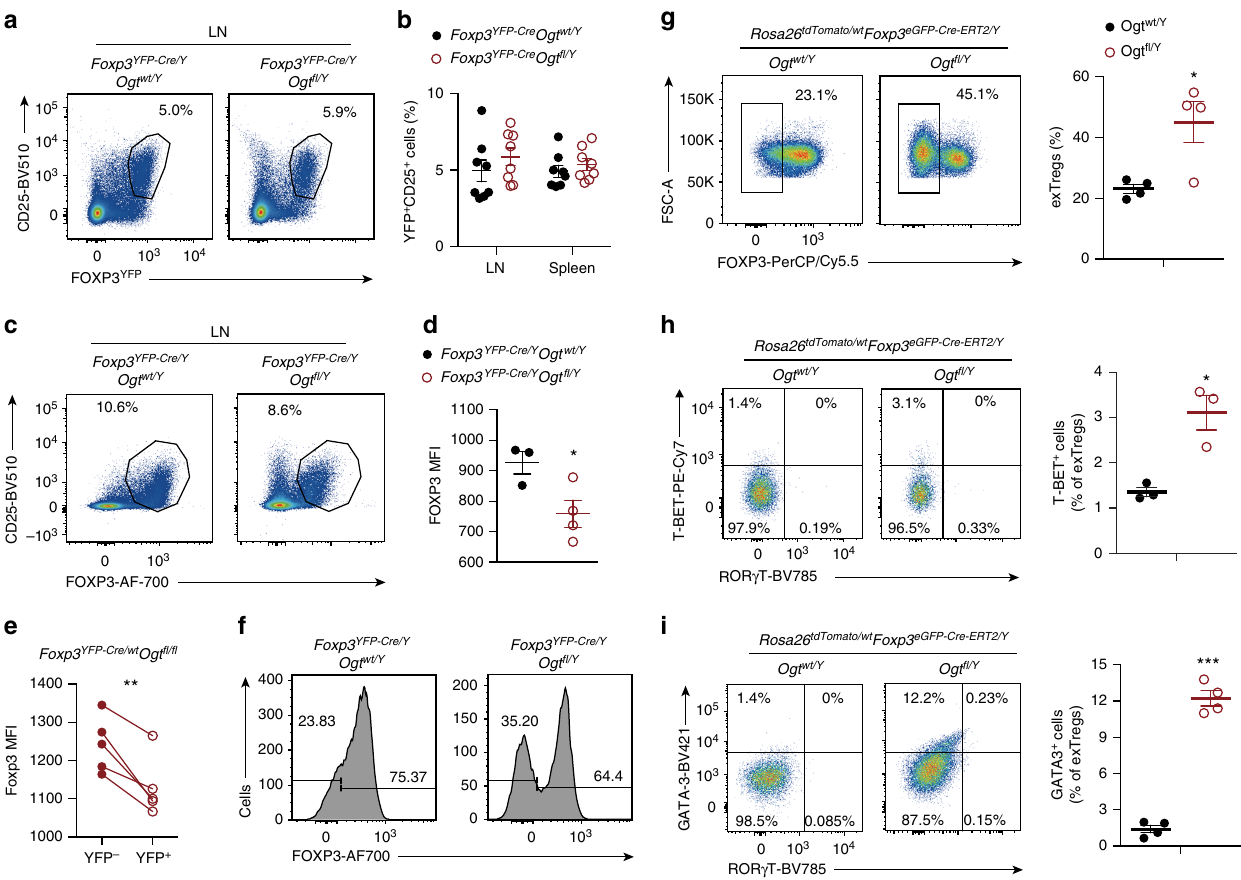
Fig. 4 Protein O-GlcNAcylation stabilizes the Treg cell lineage. a , b Flow cytometry of YFP + CD25 + cells among CD4 + T cells in the LNs ( a ) and frequencies of YFP + CD25 + cells in the LNs and spleen from 2-week-old Foxp3 YFP-Cre/Y Ogt wt/Y and Foxp3 YFP-Cre/Y Ogt fl /Y mice, n = 8 each group ( b ). c , d Flow cytometry of FOXP3 + CD25 + cells among CD4 + T cells ( c ) and MFI of FOXP3 in FOXP3 + CD25 + Treg cells ( d , n = 3 – 4) in the LNs from 2-week-old Foxp3 YFP-Cre/Y Ogt wt/Y and Foxp3 YFP-Cre/Y Ogt fl /Y mice. e MFI of FOXP3 in OGT-suf fi cient and -de fi cient Treg cells in the LNs from Foxp3 YFP-Cre/Y Ogt fl / fl mice, n = 5. f Histogram of FOXP3 expression in CD4 + CD25 + YFP + Treg cells in the LNs from 2-week-old Foxp3 YFP-Cre/Y Ogt wt/Y and Foxp3 YFP-Cre/Y Ogt fl /Y mice, n = 6 each group. g Flow cytometry and quanti fi cation of the frequencies of Td-tomato + GITR + FOXP3 − ex-Treg cells among CD4 + T cells in the LNs from Foxp3 eGFP-Cre-ERT2/Y Ogt wt/Y Rosa26 tdTomato/wt and Foxp3 eGFP-Cre-ERT2/Y Ogt fl /Y Rosa26 tdTomato/wt mice, n = 4. h , i T-BET + , GATA3 + and ROR γ T + cells among ex-Treg cells in the LNs from Foxp3 eGFP-Cre-ERT2/Y Ogt wt/Y Rosa26 tdTomato/wt and Foxp3 eGFP-Cre-ERT2/Y Ogt fl /Y Rosa26 tdTomato/wt mice, n = 3 – 4. Data are shown as mean ± s.e.m. * p < 0.05; ** p < 0.01; *** p < 0.001 by unpaired ( b , d , g – i ) and paired ( e ) student ’ s t